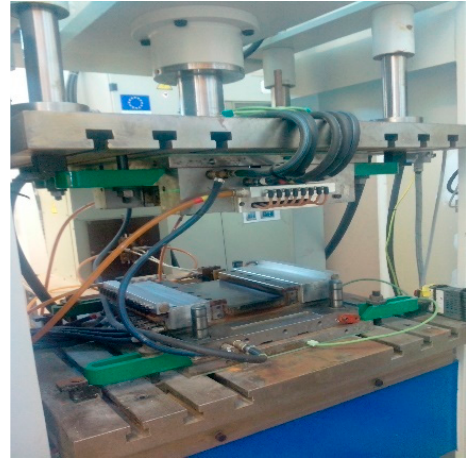
Figure 2. Compression molding